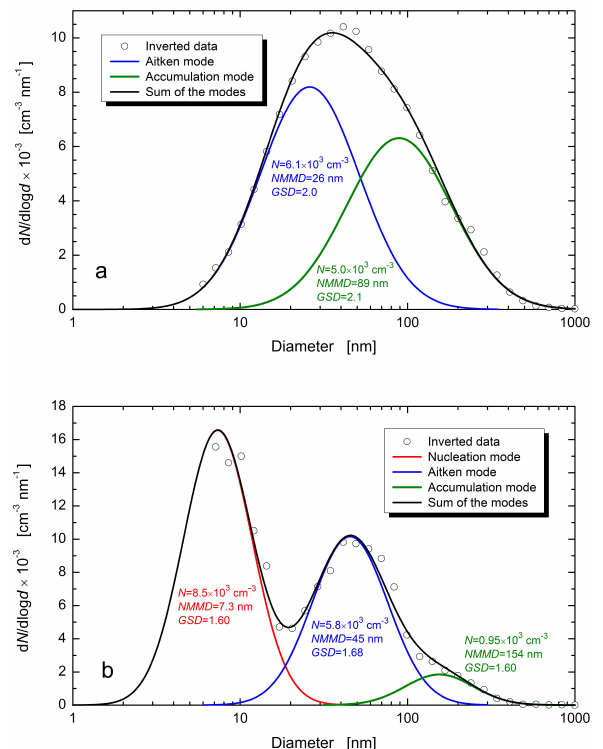
Fig. 4. Monthly mean number size distribution of atmospheric aerosol particles for September 2009 (a) , and number size distri- bution of atmospheric aerosol particles after a new particle forma- tion event for 10:00 on 8 May 2009 (b) . Modal concentrations ( N) , number median mobility diameters (NMMD) and geometric stan- dard deviations (GSD) for the nucleation, Aitken and accumulation modes are also shown.